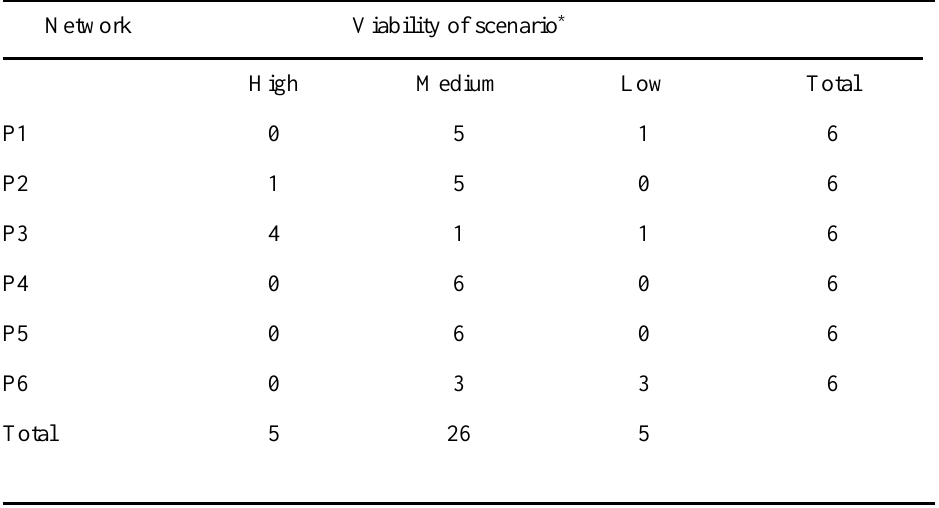
Table 6. Number of scenarios under different levels of viability based on six types of